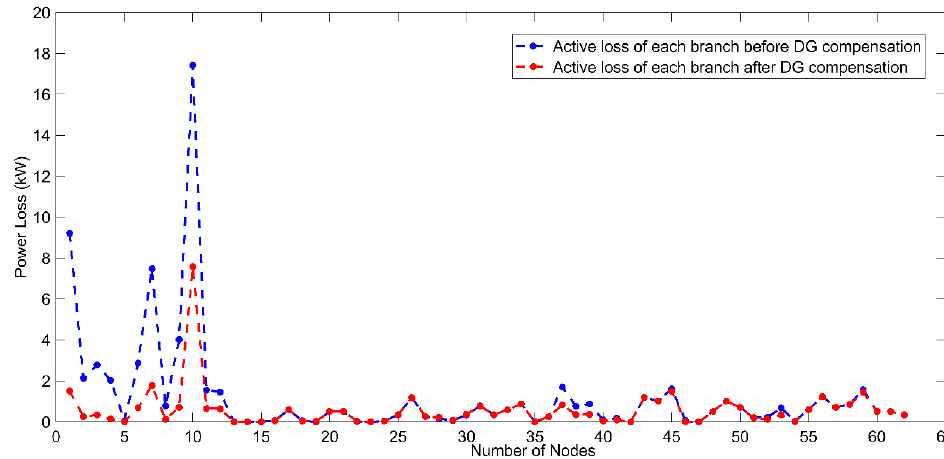
Figure 7. Comparison of active loss of each branch before and after DG access.